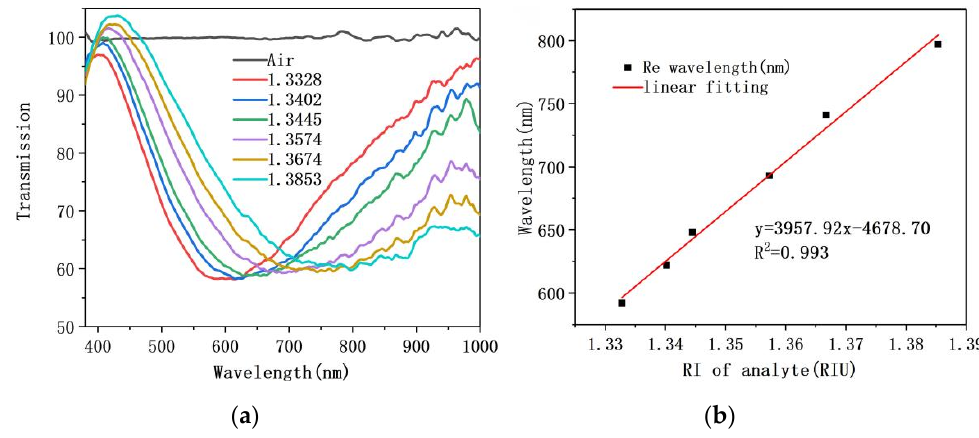
Figure 12. ( a ) Resonance spectrum of fiber/Ag-Cu films SPR sensor as the refractive index of the analyte increases; ( b ) The sensitivity fitting curve. Table 1. The detailed performance comparison of two sensors proposed in this paper.